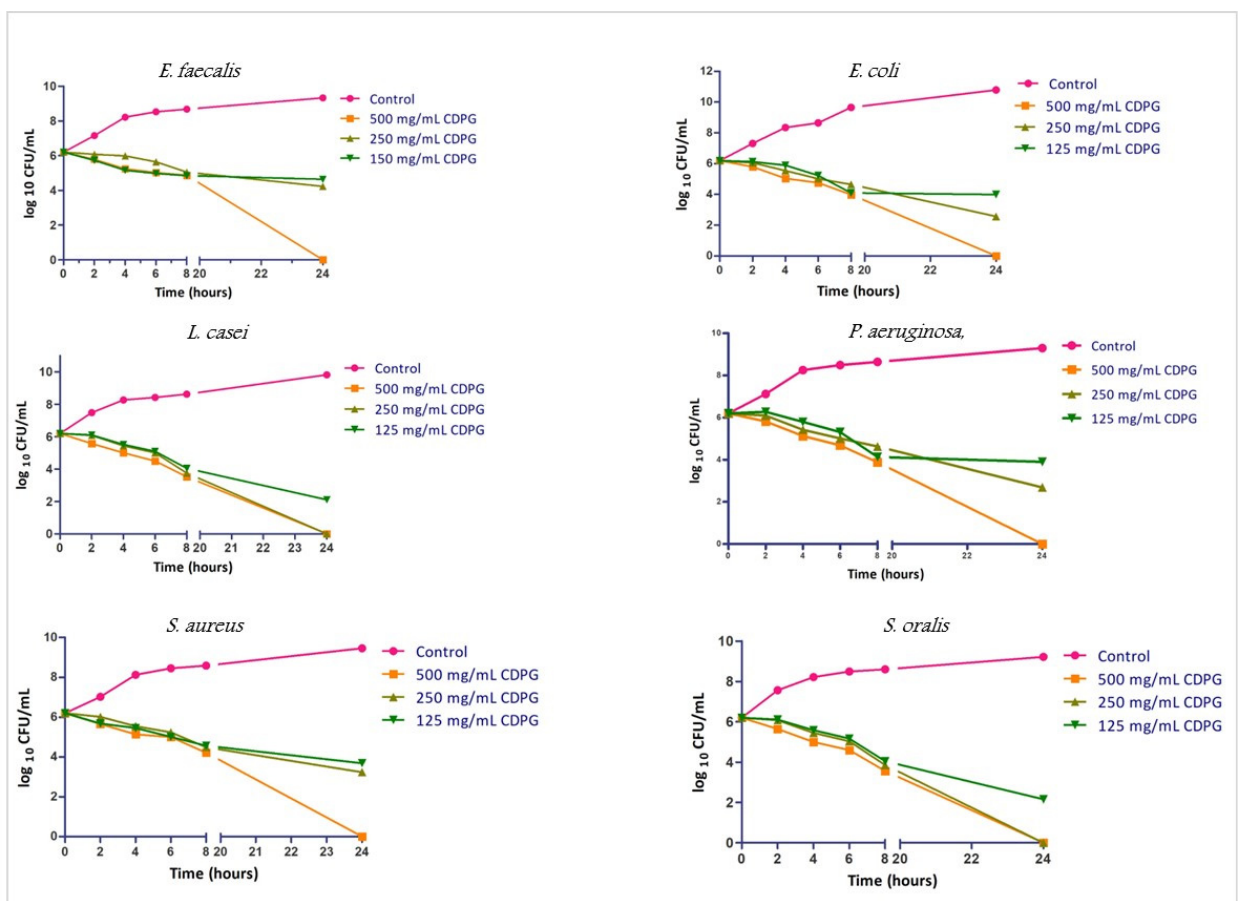
Figure 2. Time Kill assay of different bacteria.